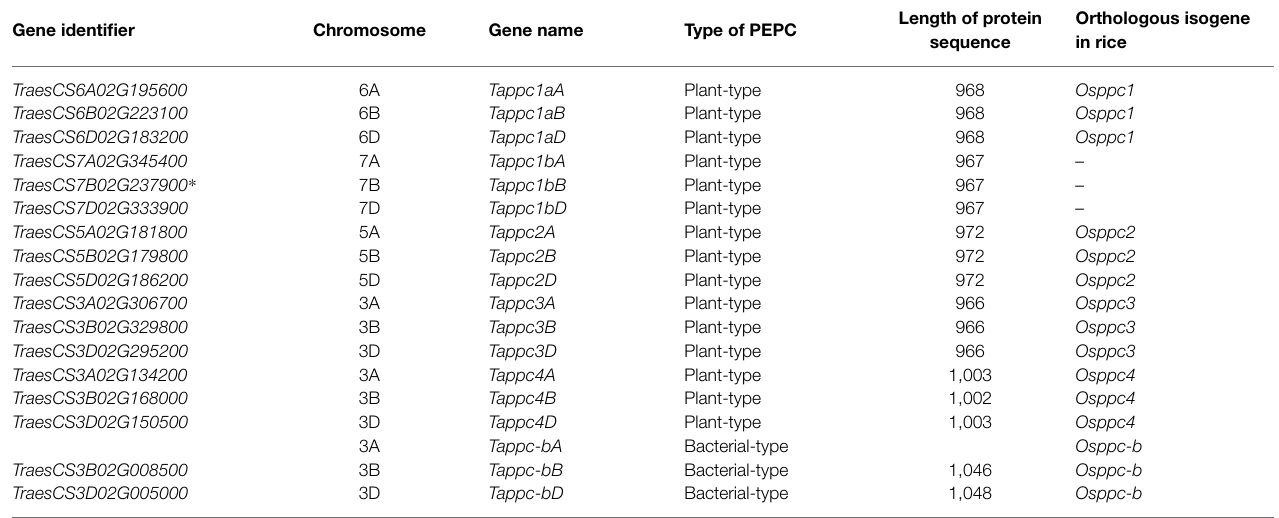
TABLE 1 | PEPC isogenes in the wheat